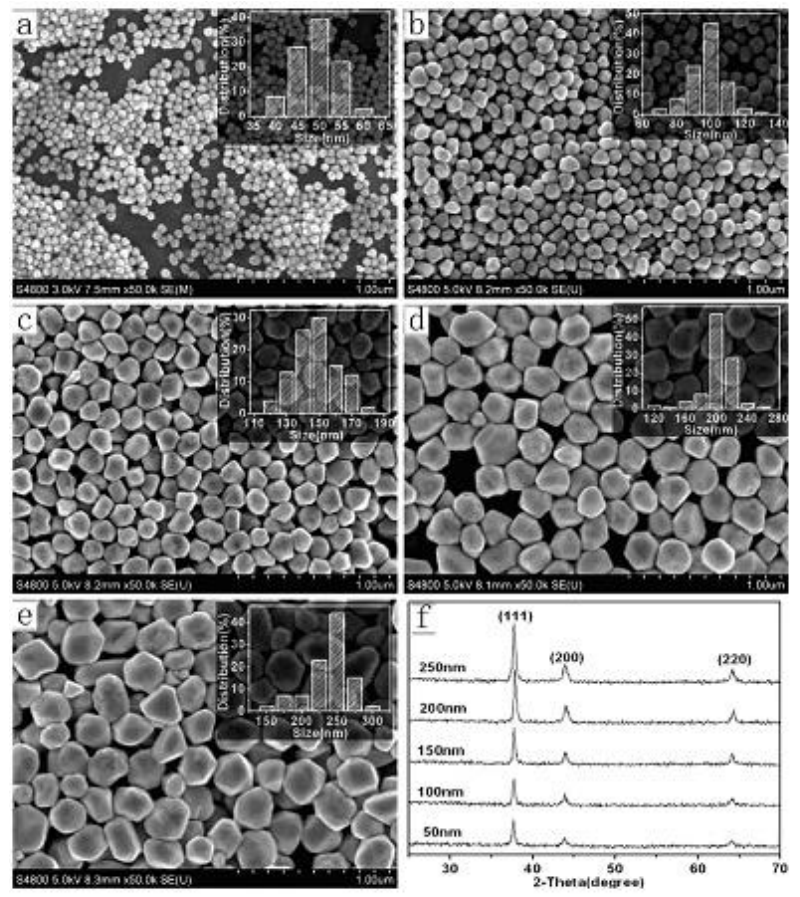
Figure 7. FE-SEM images of 50 nm Ag seeds ( a ) and as-prepared products of quantitative size-controlled and size-designed synthesis with sizes of ( b ) 100 nm; ( c ) 150 nm; ( d ) 200 nm; and ( e ) 250 nm. Reaction times are 16 h, insets are the corresponding size-distribution histograms; ( f ) shows the XRD patterns corresponding to ( a – e ) (reprinted with permission from [56]. Copyright (2010) American Chemical